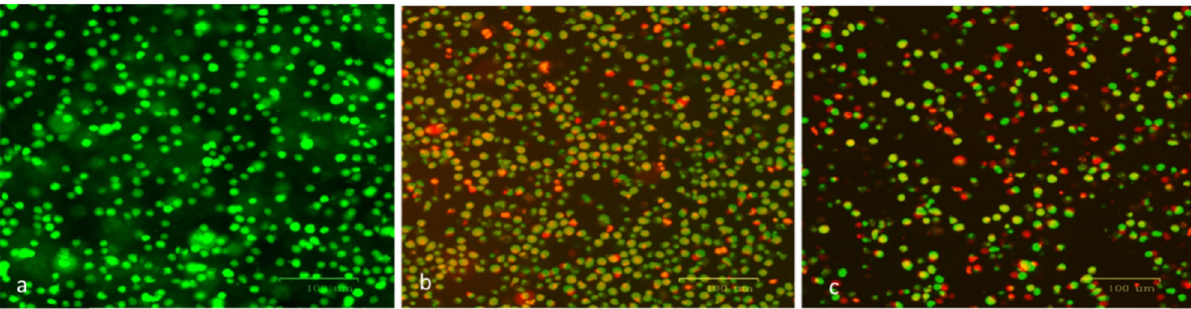
Figure 8: Apoptosis was determined in MOLT4 cells by using AO/EtBr dual staining following treatment with IC 50 doses of ZnO – TiO 2 – chitosan – escin bio - nanocomposites. Cells in green color indicated live cells, yellowish red color cells indicated early apoptotic cells, and red color cells indicated late apoptotic cells. ( a ) Untreated control cells, ( b ) cells treated with 30 μ g · mL − 1 , and ( c ) 40 μ g · mL − 1 of ZnO – TiO 2 – chitosan – escin bio - nanocomposite. These are representative images of the experiment performed in triplicates with magni fi - cation at 20 × .